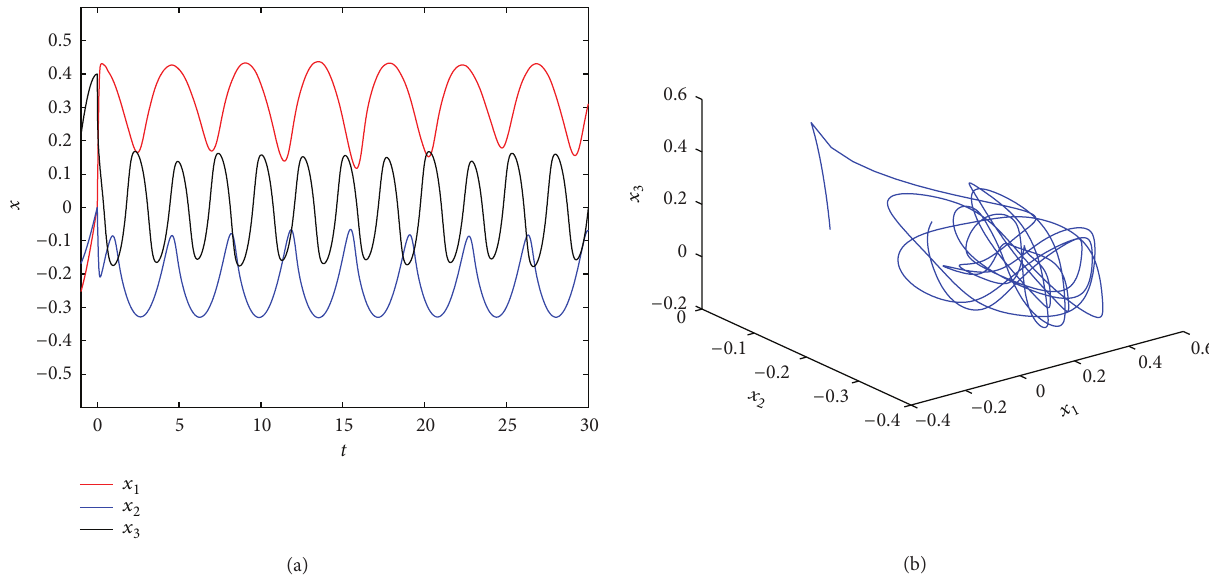
Figure 2: The state trajectory of the network with the initial condition (𝜑 1 (𝑡),𝜑 2 (𝑡),𝜑 3 (𝑡)) 𝑇 = (0.3 sin 𝑡,0.2 sin 𝑡,0.4 cos 𝑡) 𝑇 , 𝑡 ∈ [−1, 0) . (𝑡)󵄨󵄨󵄨󵄨 󵄨󵄨󵄨󵄨𝑥 < 1, {0.7, 2 𝑏 (𝑥 ) = 23 2 0.8,